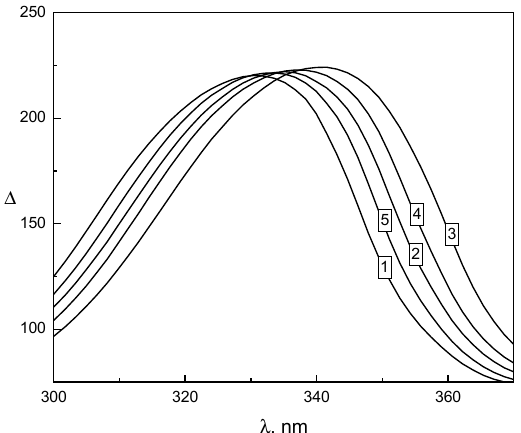
Figure 4. Ellipsometric parameter Δ vs. λ peak position at different time instances: (1) pAAO/air at λ = 330 nm; (2) pAAO/HSA (1 h incub.) at λ = 335 nm; (3) pAAO/HSA (2 h incub.) at λ = 341 nm; (4) pAAO/HSA (3 h incub. + 15 min wash) at λ = 336 nm; (5) pAAO after washing with deionised water at λ = 333 nm.